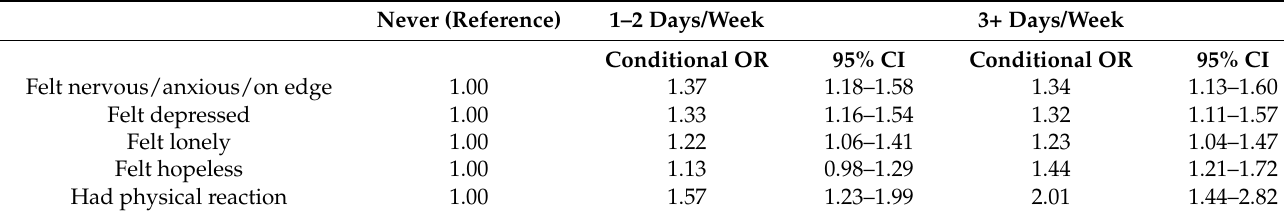
Table 5. Conditional odds ratios and 95% CI of mental health symptoms of adults with allergies. Never (Reference) 1–2 Days/Week 3+